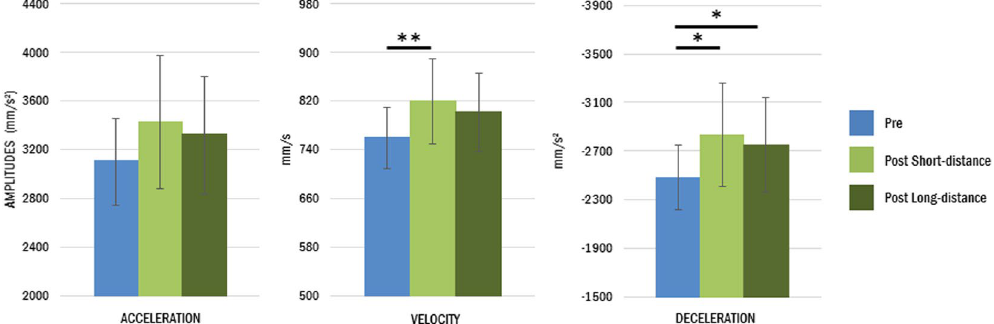
Figure 8. Movement kinematics following changes in arm posture. After both short- (light green) and long- distance sessions (dark green), participants showed higher peaks compared to before (blue). These changes are in the opposite direction to the ones induced by tool use in Experiment 1. Latencies (not shown) were not significantly modified. Asterisks denote significant differences between pre and post sessions. * < 0.05; ** < 0.01; Bars illustrate mean values for each parameter and the 95% confidence